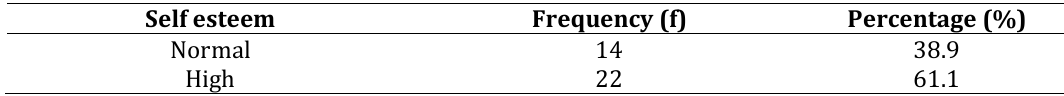
Level of self-esteem after life-review